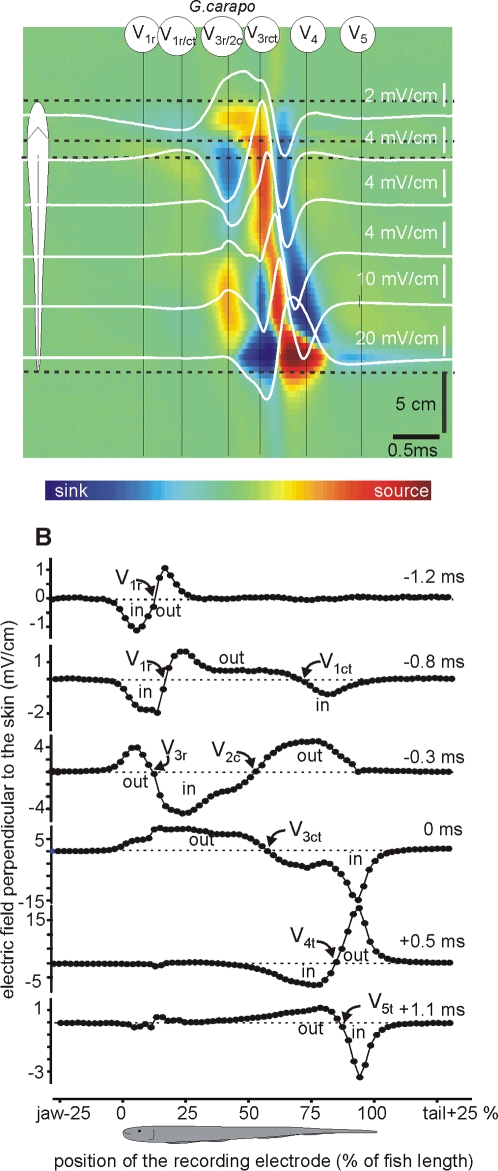
Transcutaneous current pattern of G. carapo.Electric field perpendicular to the main axis of the fish body was recorded along a line 2 mm parallel to the fish side of G. carapo (same resolution and color code as in Figure 2). This species shows the more complicated generator. We refer to each generator referring to its temporal order (numeral sub index) and spatial origin (literal sub index, r for rostral, c for central, and t for tail). Times are referred to the positive peak (0 ms). The first observed activity is caused by a much localized sink at the head and a source distributed on the abdominal region (reversal point about 10–15% of the fish length from the jaw, V1r). It is followed by a distributed activity corresponding to more than one generator. In fact, two sinks at the head and at the tail regions indicate two simultaneous spots of activity in the electric organ at about 0.8 ms before the positive peak (reversal points about 20 and 75%,). Half a ms later the rostral activity reverses direction while at the central region a more distributed sink (having its source at the tail) develops. The complex V34ct (labels: 0 and 0.5 ms) has the same profile as in the other species and finally the electric organ discharge ends with a rebound (label: 1.1 ms, V5).